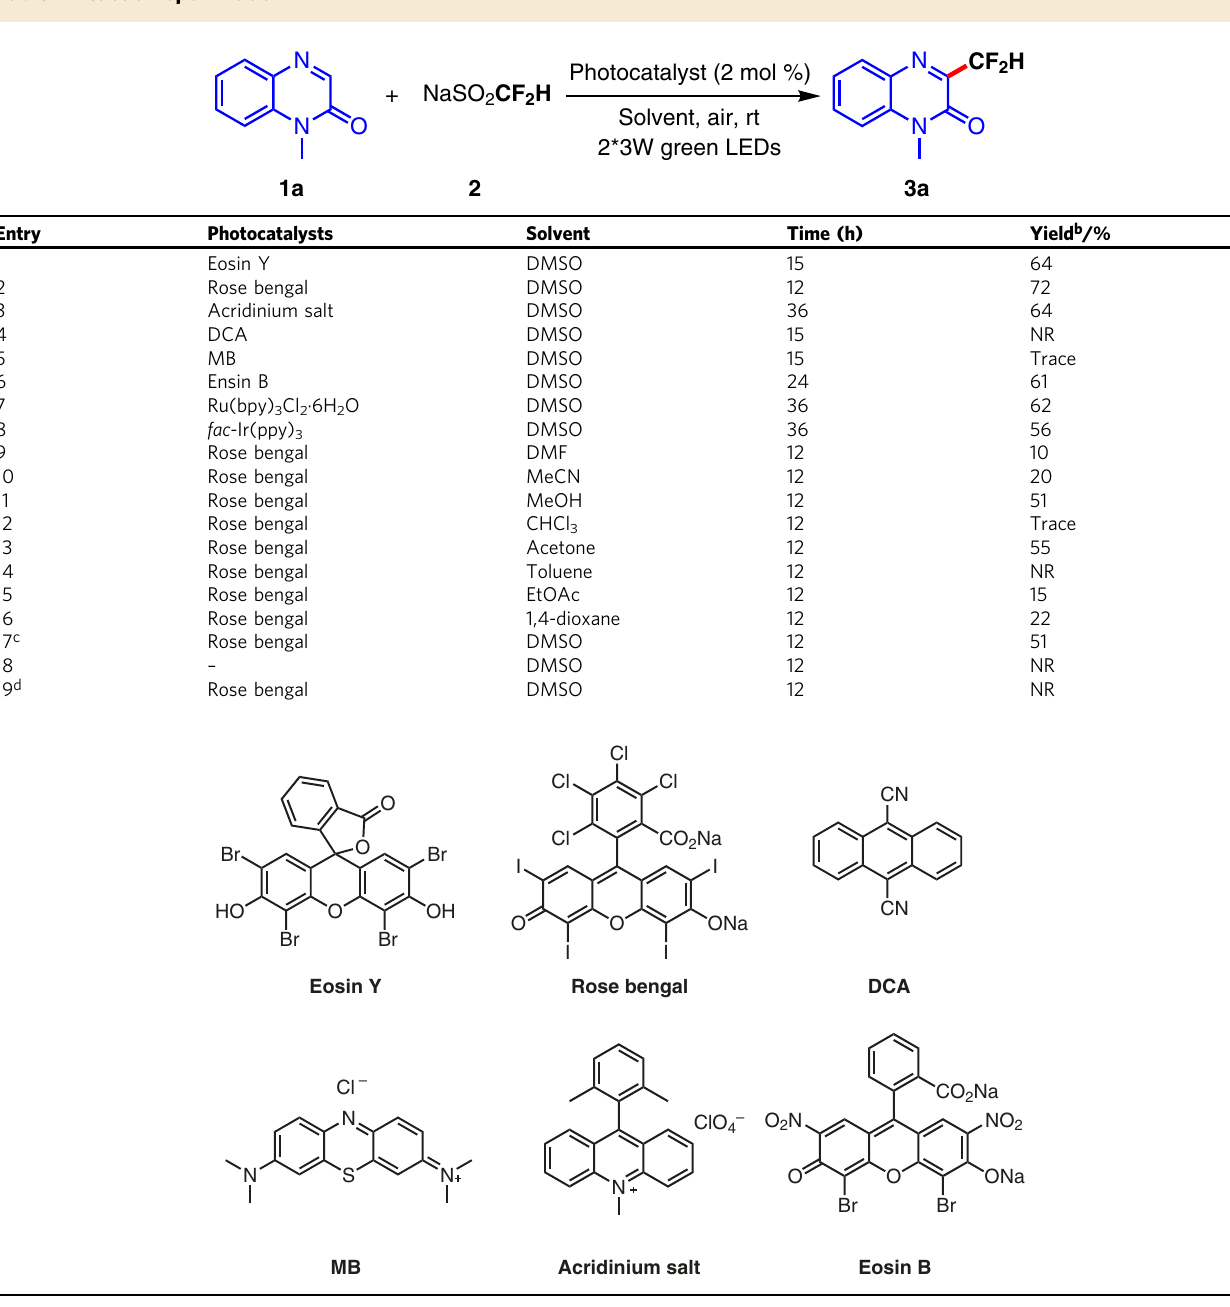
Table 1 Reaction optimization a,b